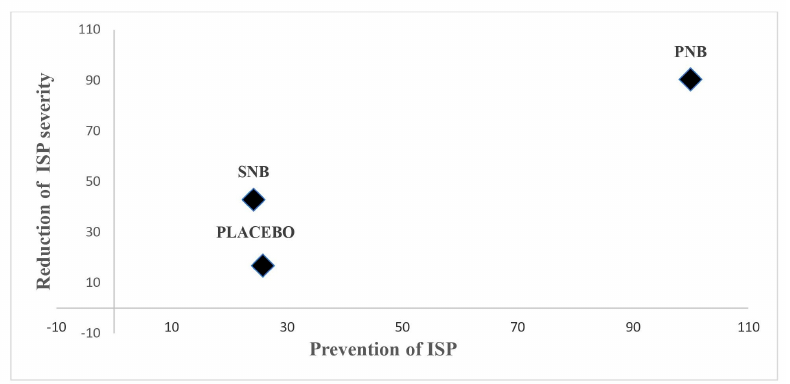
Figure 7. Ranking plot for ipsilateral shoulder pain network during 24 h postoperative period. Treatments have been ranked according to the surface under cumulative ranking curves (SUCRA) between the effective treatment of the incidence and severity of ISP. Each plot was located according to their SUCRA values of each anesthetic intervention for two outcomes. The larger SUCRA value mean a better ranking of the intervention. PNB has the highest SUCRA value and is regarded as the most preferred intervention for prevention and reduction of ISP severity. SUCRA, the surface under cumulative ranking curves; ISP, ipsilateral shoulder pain; PNB, phrenic nerve block; SNB, suprascapular nerve